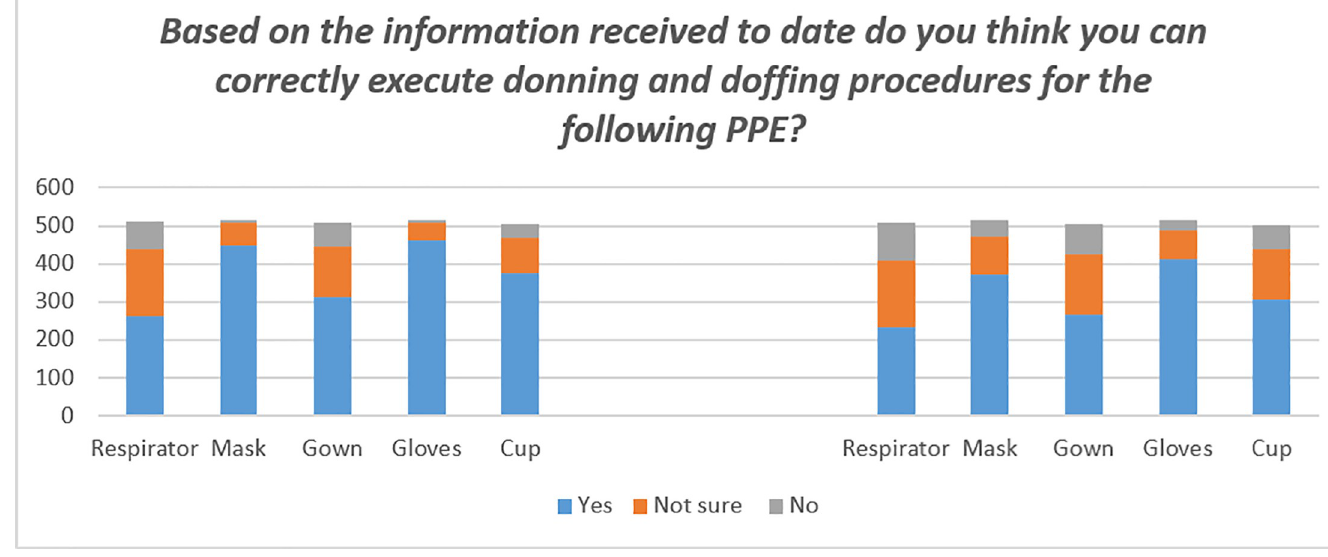
PLOS ONE | https://doi.org/10.1371/journal.pone.0239024 October 12,